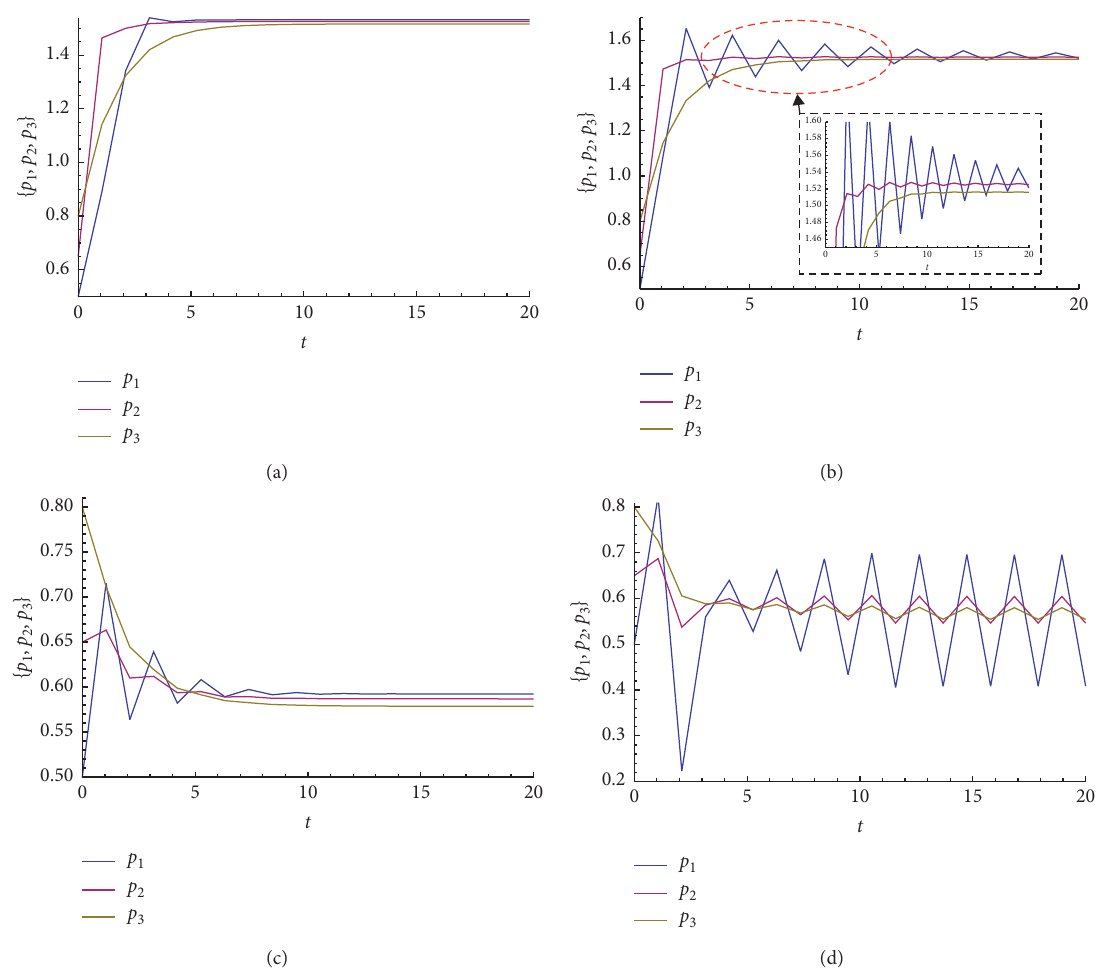
Figure 6: The trajectory changes of p α � 0 . 6 ,d � 0 . 1. (d) α � 0 . 6 ,d � 0 . 7.